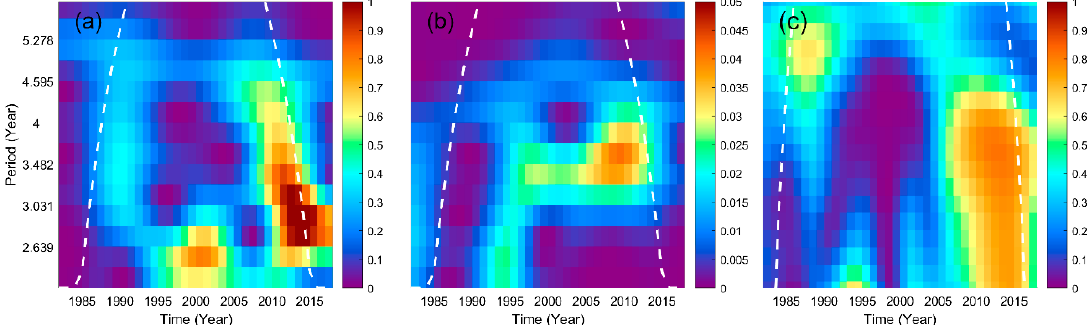
Figure 9. Wavelet analysis of ( a ) AO index in winter; and ( b ) SSTA in ELDs; and ( c ) wavelet coherence of ( a ) and ( b ).